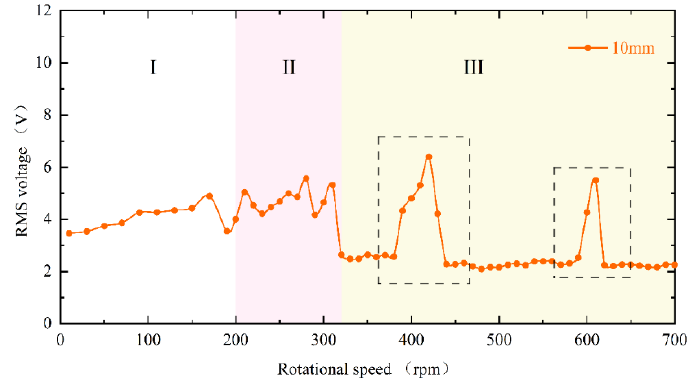
Figure 4. Experimental results of inverse beam RMS voltage at 10 mm magnet spacing.